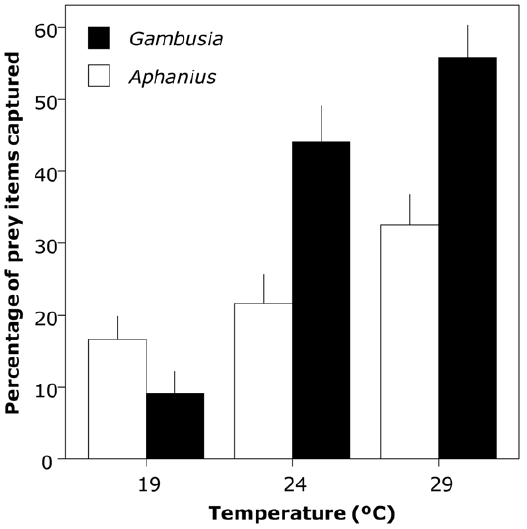
Figure 3. Effects of temperature on the number of prey items captured by Gambusiaholbrooki and Aphaniusiberus . Means and SE (error bar) are shown. Note that the totals for both species for 19 and 24 u C do not equal 100%. This reflects the prey that remained uneaten.